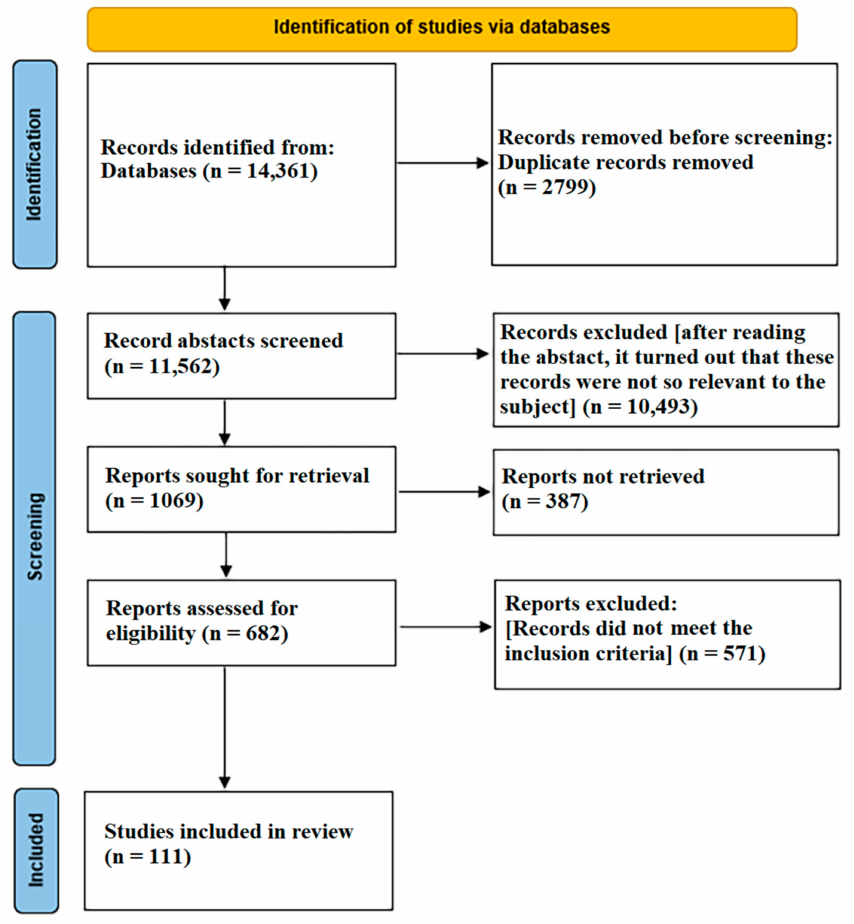
Figure 2. PRISMA flow diagram for the narrative review which included searches of